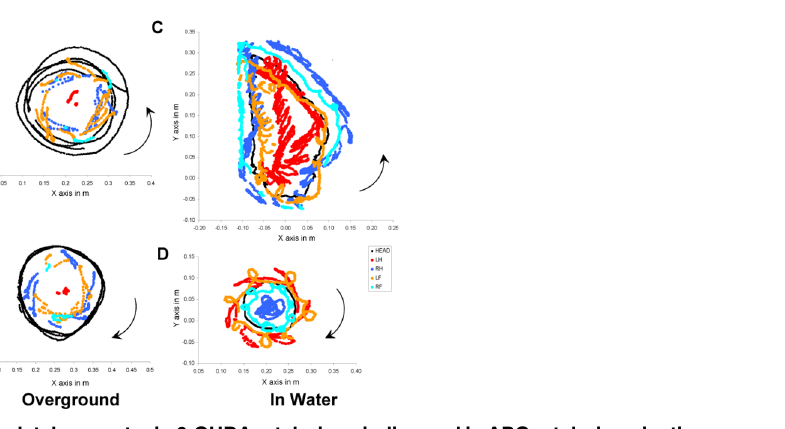
Fig 4. Skeletal geometry in 6-OHDA rat during circling and in APO rat during pivoting over ground and in water. Examples reconstructed from films captured at 200 Hz by a multi-cameras system. (A, B) Trajectories of the head and the extremities of the four limbs according to the earth horizontal plane (x,y) during the totality of the sequence of recording (11 s) on the ground. (A) The 6-OHDA rat turns in an anticlockwise direction (ipsiversive side to the lesion). The head describes concentric circles and the snout and the vibrissae are in contact with the surface. Limb data are incomplete because landmarks are often hidden by the body of the rat. However, the hindlimb ipsilateral to the lesion is used as a pivot by the rat during its rotation, and the position of the others footfalls are inside the head trajectory. (B) All the trajectories of the head of the APO rat (the same shows in A after APO injection) are superimposed, and turn in clockwise direction (contraversive side to the lesion). The hind limb ipsilateral to the lesion is used as a pivot, as in the 6-OHDA, but the other limb shows a backward movement inducing the change of the direction of pivoting. The position of the footfalls of the other limbs do not change, and are also inside the trajectories of the head. (C, D) Trajectories of the head and the extremities of the four limbs in the water according to the water surface (x,y) during only one revolution (2.25 s) to facilitate the data visualization. The position of the head in 6-OHDA and APO rat is very horizontal and the snout stays at the limit between the water and the air so that the rat can breathe. (C) The 6-OHDA rat turns as overground, in an anticlockwise direction (ipsiversive side to the lesion). The trajectories of the limbs ipsilateral to the lesion are inside or close to the trajectories of the head. The introduction of a lateral component is characterized by trajectories of the limbs contralateral to the lesion outside of the head trajectories. (D) The APO rat turns as in over ground in a clockwise direction (contraversive side to the lesion). The forelimbs move out of phase, with a stronger lateral component for the forelimb ipsilateral to the lesion. The hindlimbs present alternate movements, the trajectory of the hindlimb contralateral to the lesion is close to the center of rotation, while the hindlimb ipsilateral to the lesion exhibits the larger lateral trajectory. All of these characteristics induce a faster and tighter rotation of the APO rat in comparison with the 6-OHDA rat. HEAD; marker on the snout. RF; Right forelimb. RH; Right hindlimb. LF; Left forelimb. RH; Right hindlimb. Scale units are in meters. Arrows indicate the direction of the movement. The different axis have the same scale in meter.